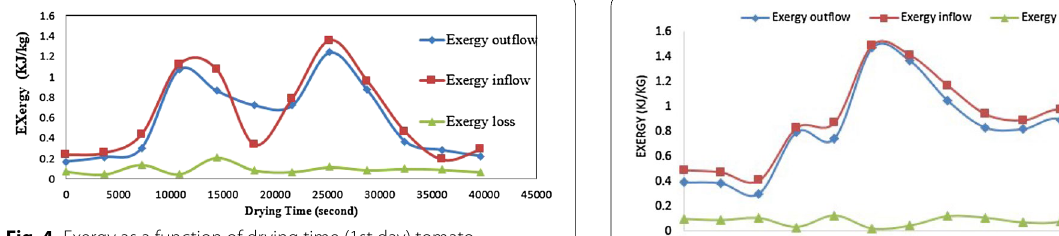
Fig. 4 Exergy as a function of drying time (1st day) tomato